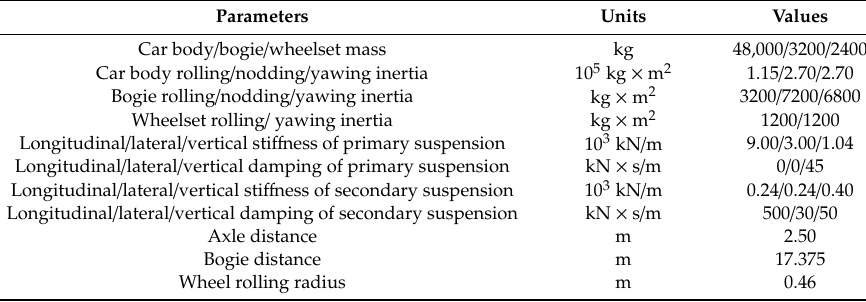
Table 1. Model parameters of high-speed vehicle of